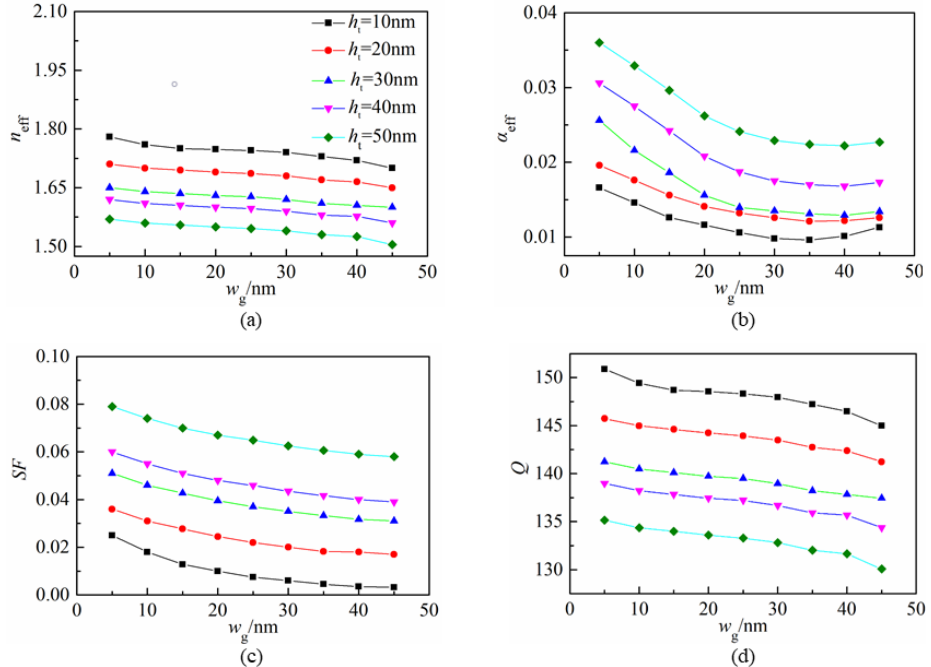
Figure 4. The mode properties change with the air gap, w g, and the distance, h t ; ( a ) effective index, n eff ; ( b ) effective propagation loss, α eff ; ( c ) normalized mode area, SF; ( d ) confinement factor, Γ.